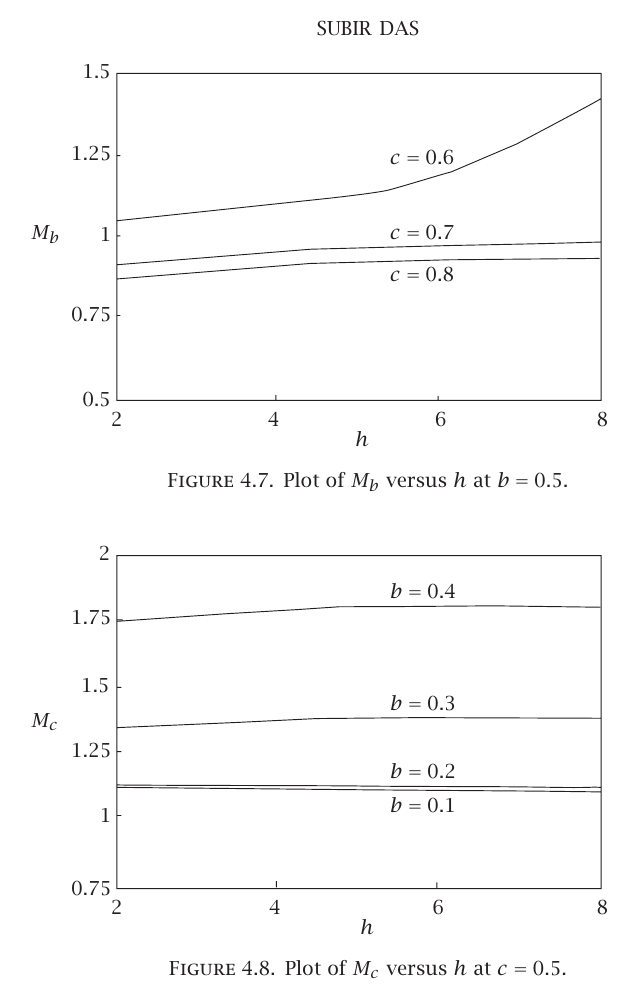
Figure 4.8 . Plot of M c versus h at c = 0 . 5.